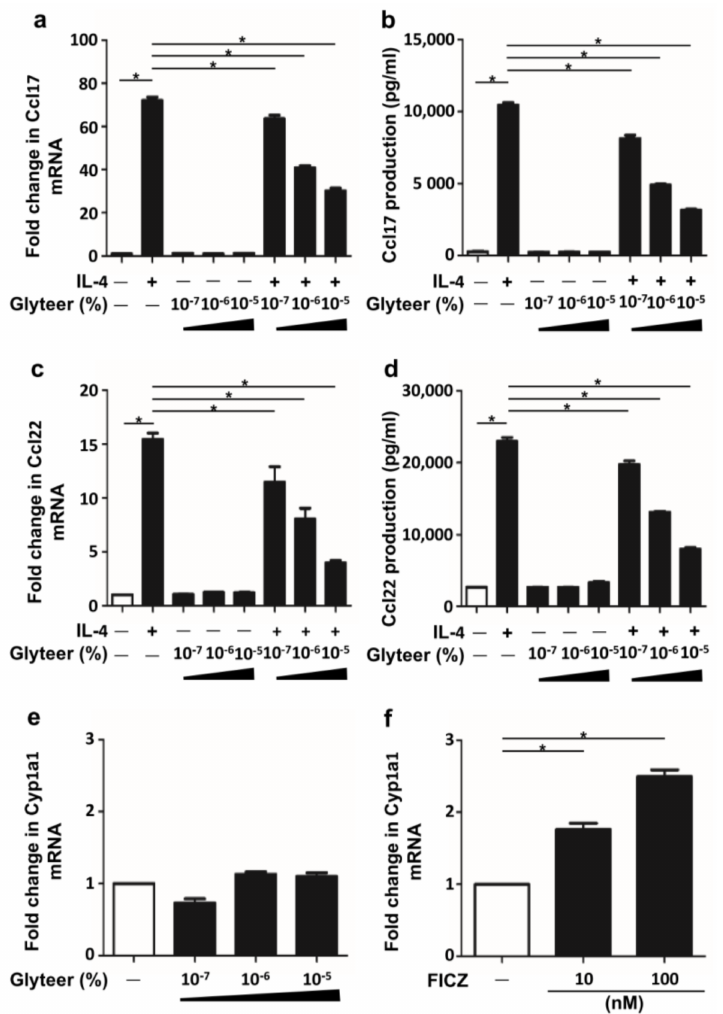
Figure 2. Glyteer treatment inhibited IL-4-induced Ccl17 and Ccl22 production in BMDCs. ( a – f ) Data are expressed as mean ± S.E.M.; n = 3 for each group; * p < 0.05. IL-4-simulated BMDCs were treated with Glyteer or 6-formylindolo[3.2-b]carbazole (FICZ) at the indicated dose for 24 h. Expression of Ccl17 ( a ) and Ccl22 ( c ) in BMDCs was analyzed by Quantitative Reverse Transcription (qRT)-PCR. Production of Ccl17 ( b ) and Ccl22 ( d ) in culture supernatant was measured by ELISA. Expression of Cyp1a1 in BMDCs treated with Glyteer ( e ) or FICZ ( f ) was analyzed by